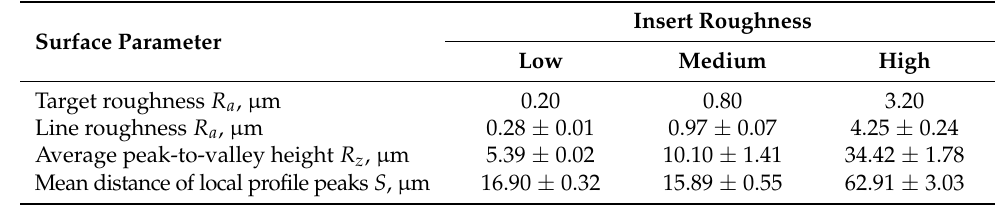
Table 7. Surface parameters of the applied inserts.